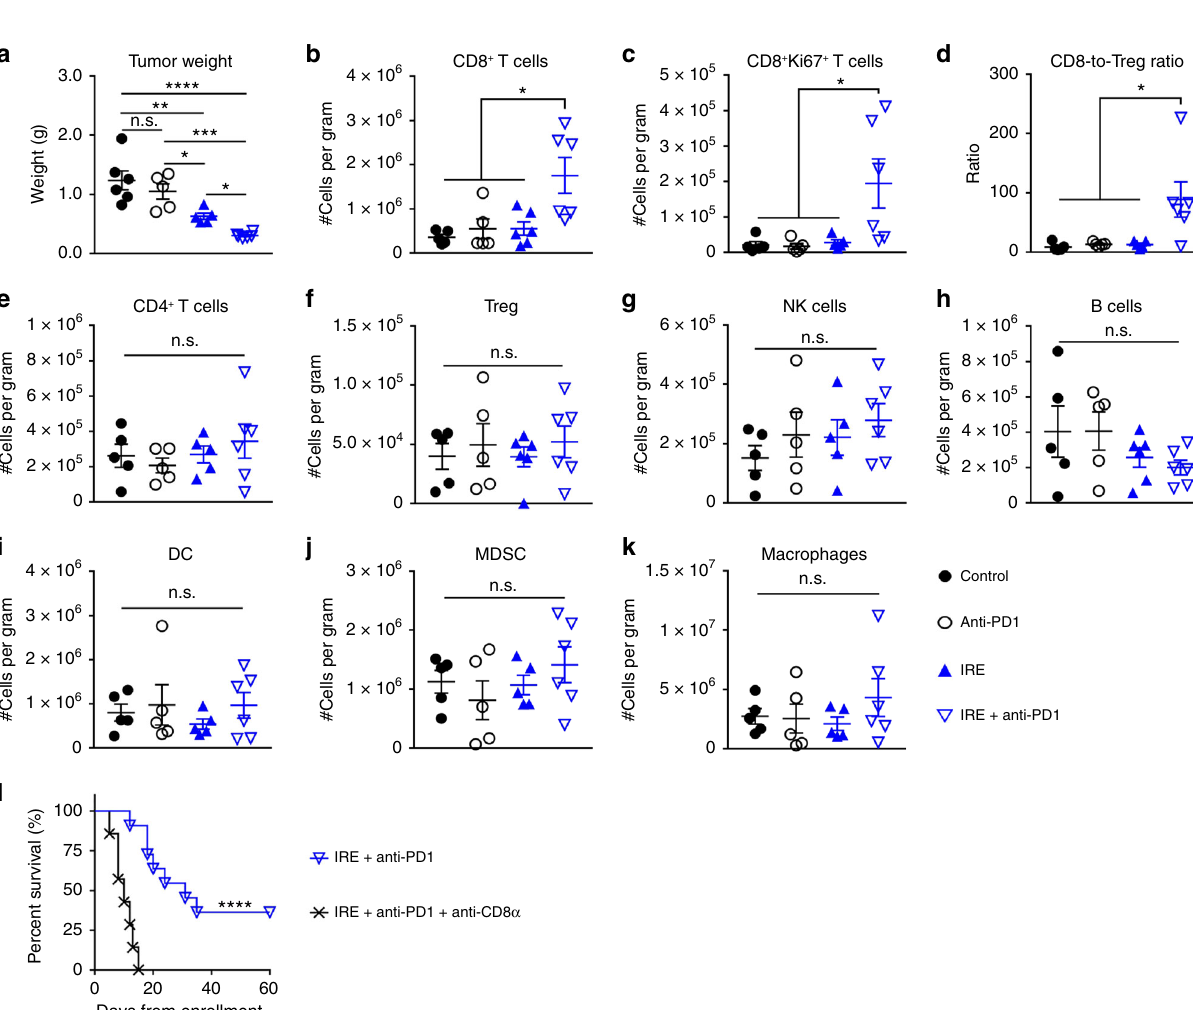
Fig. 3 Pro fi ling of intratumoral immune cells in KRAS* tumors. a Tumor weights at 9 days after initiation of treatments. b Frequency of CD8 + T cells (CD3 + CD8 + ). c Frequency of proliferating CD8 + T cells (CD8 + Ki67 + ). d CD8 + -to-Treg cell ratio. e Frequency of CD4 + T cells (CD3 + CD4 + ). f Frequency of Tregs (CD4 + CD25 + Foxp3 + ). g Frequency of NK cells (NK1.1 + ). h Frequency of B cells (CD19 + ). i Frequency of DCs (CD11c + CD11b − ). j Frequency of MDSCs (CD11c + CD11b + Ly6C + and CD11c + CD11b + Ly6G + ). k Frequency of macrophages (F4/80 + ). Five tumors per group from the sham control (black solid circle), anti-PD1 (black circle), and IRE (blue solid triangle) groups, and 6 tumors from IRE + anti-PD1 group (blue triangle) were collected 9 days after initiation of treatments. Data are presented as mean ± standard error of mean (SEM). Signi fi cance of differences was determined using 1-way ANOVA followed by Tukey post hoc analysis. l Kaplan – Meier survival curves showing the effect of CD8 neutralization. Mice in the IRE + anti-PD1 + anti-CD8 α (black x, n = 7) had signi fi cantly shorter survival compared to that in the IRE + anti-PD1 group ( n = 11), log-rank test. * p < 0.05, ** p < 0.01, *** p < 0.001, **** p < 0.0001, n.s. not signi fi cant. Source data are provided as a Source Data fi